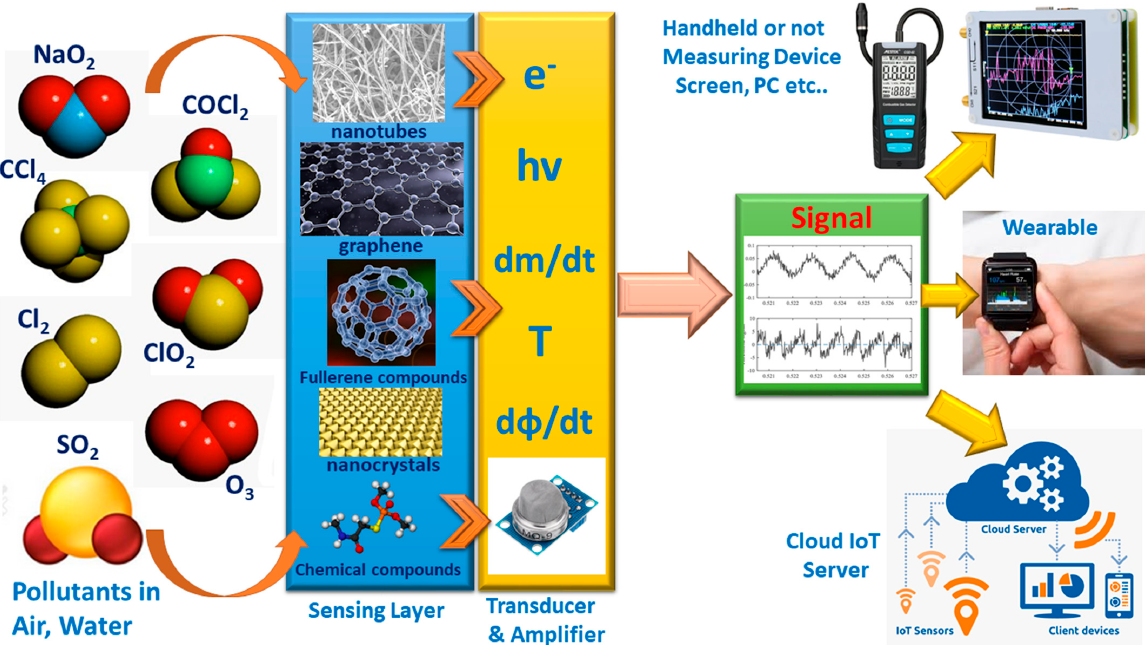
Figure 2. Schematic function-diagram of the functions of a modern chemosensor with its variants (wearable, device, and cloud-based).